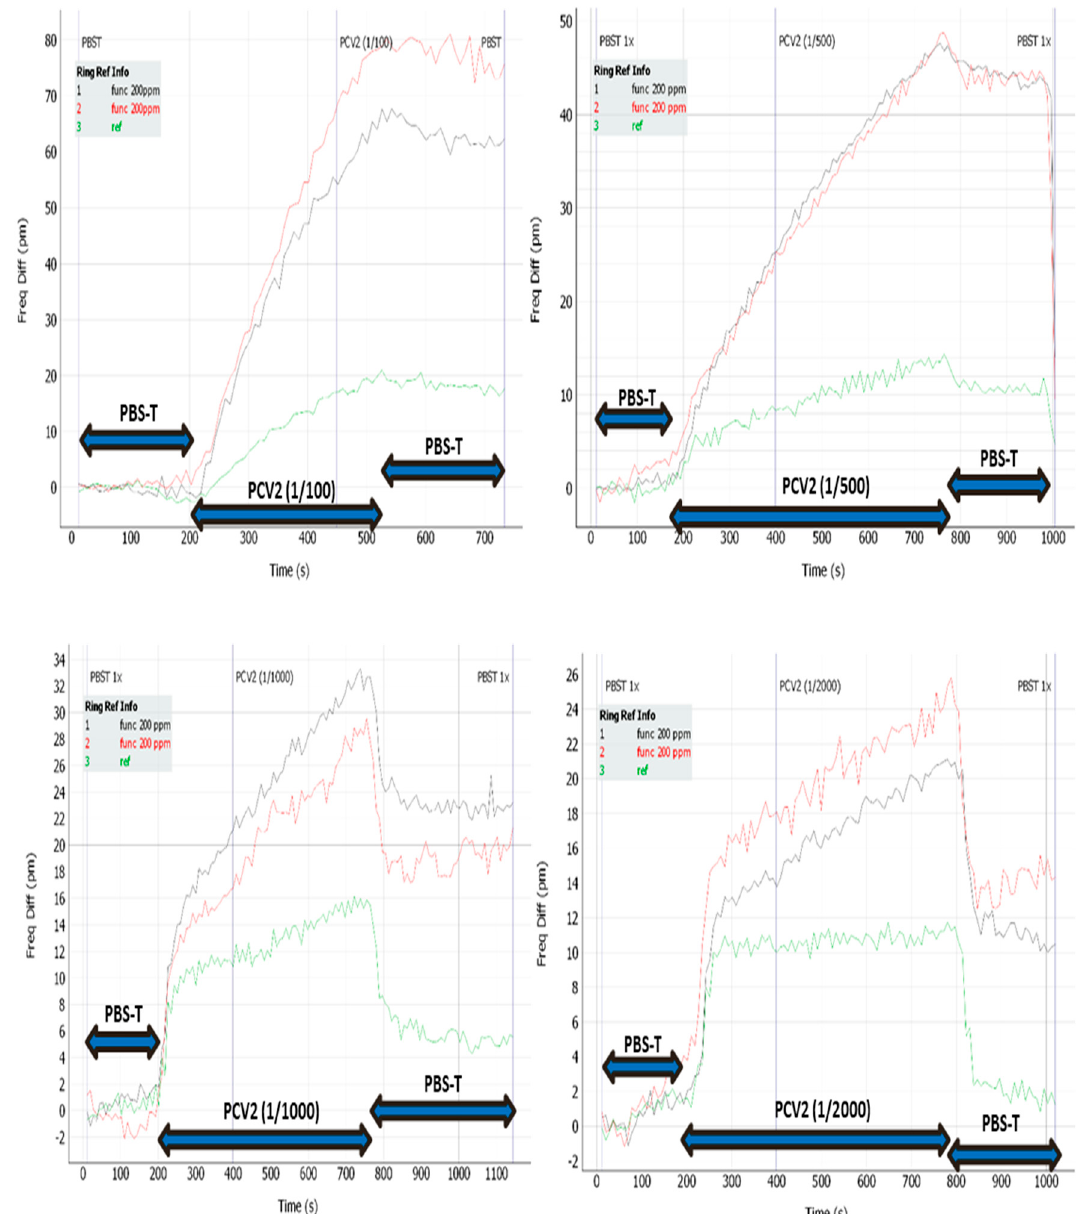
Figure 7. Optical measurements with different PCV2 virus concentrations.